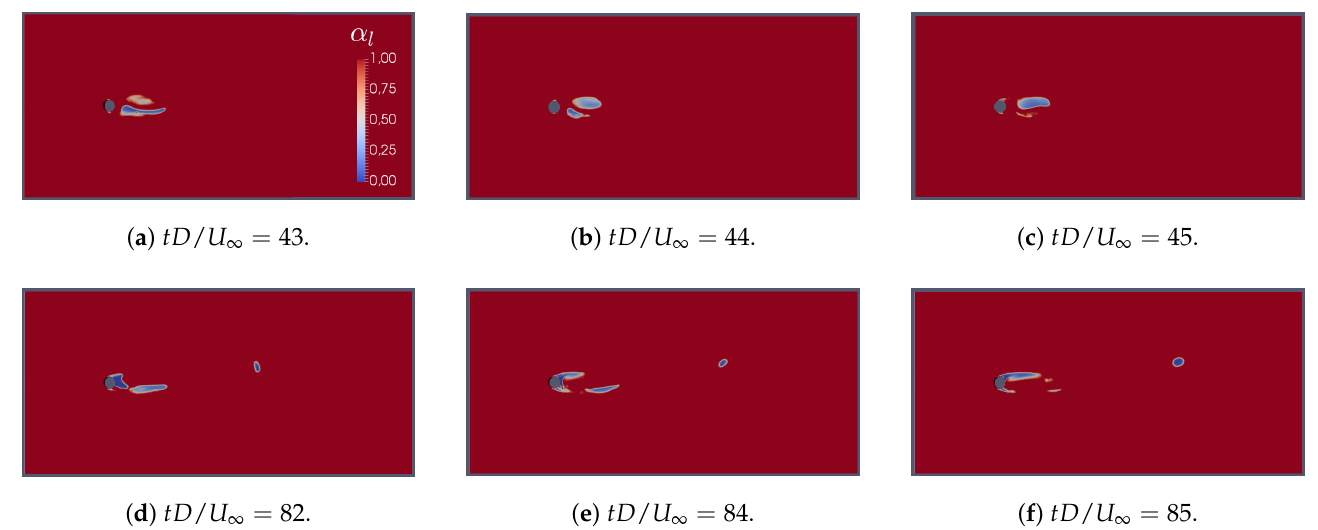
Figure 14. Contour plot of instantaneous liquid fraction, results obtained with Kunz model and considering analytical-based coefficients (Table 3).